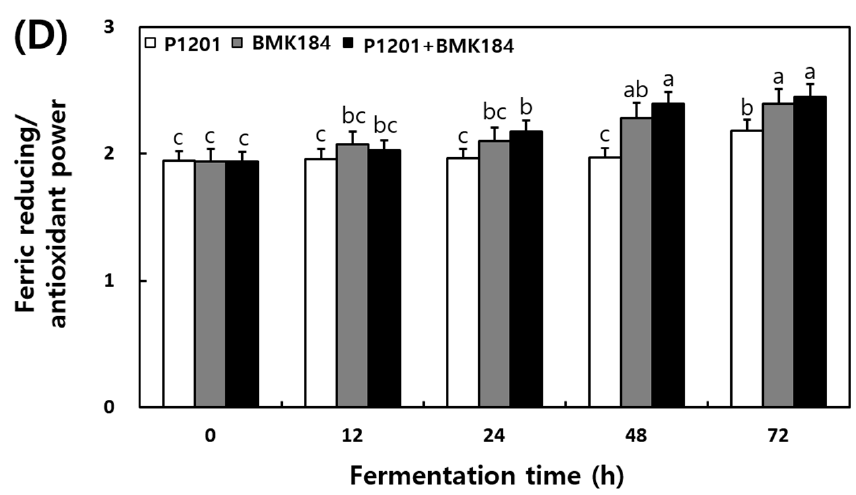
Figure 2. Changes of antioxidant effects during the fermentation of isoflavone-enriched soybean leaves (IESLs) with the use of Lactiplantibacillus plantarum P1201 and/or Levilactobacillus brevis BMK184 as starters. Samples: The IESLs were fermented at 35 °C for 72 h, with the use of Lactiplantibacillus plantarum P1201 and/or Levilactobacillus brevis BMK184 as starters. ( A ) DPPH radical scavenging activity, ( B ) ABTS radical scavenging activity, ( C ) Hydroxyl radical scavenging activity, and ( D ) Ferric reducing/antioxidant power. All values represent the means of the determinations per-